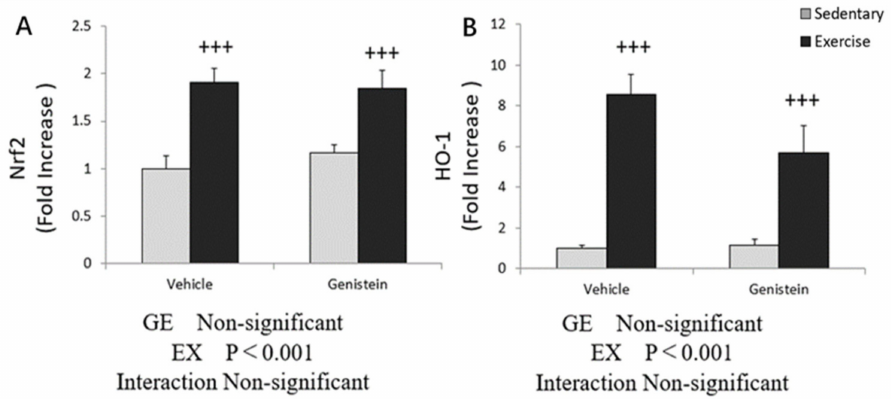
Figure 6. ( A ) Nrf2 mRNA (Con, n = 7; GE, n = 7; Ex, n = 7; GE + EX, n = 7); ( B ) HO-1 mRNA (Con, n = 7; GE, n = 7; Ex, n = 7; GE + EX, n = 7), vehicle: non-supplemented groups (only administrated with 0.5% CMC-Na solution); GE: GE-supplemented groups. +++ p < 0.001, the main effect of exercise. Values are means ±